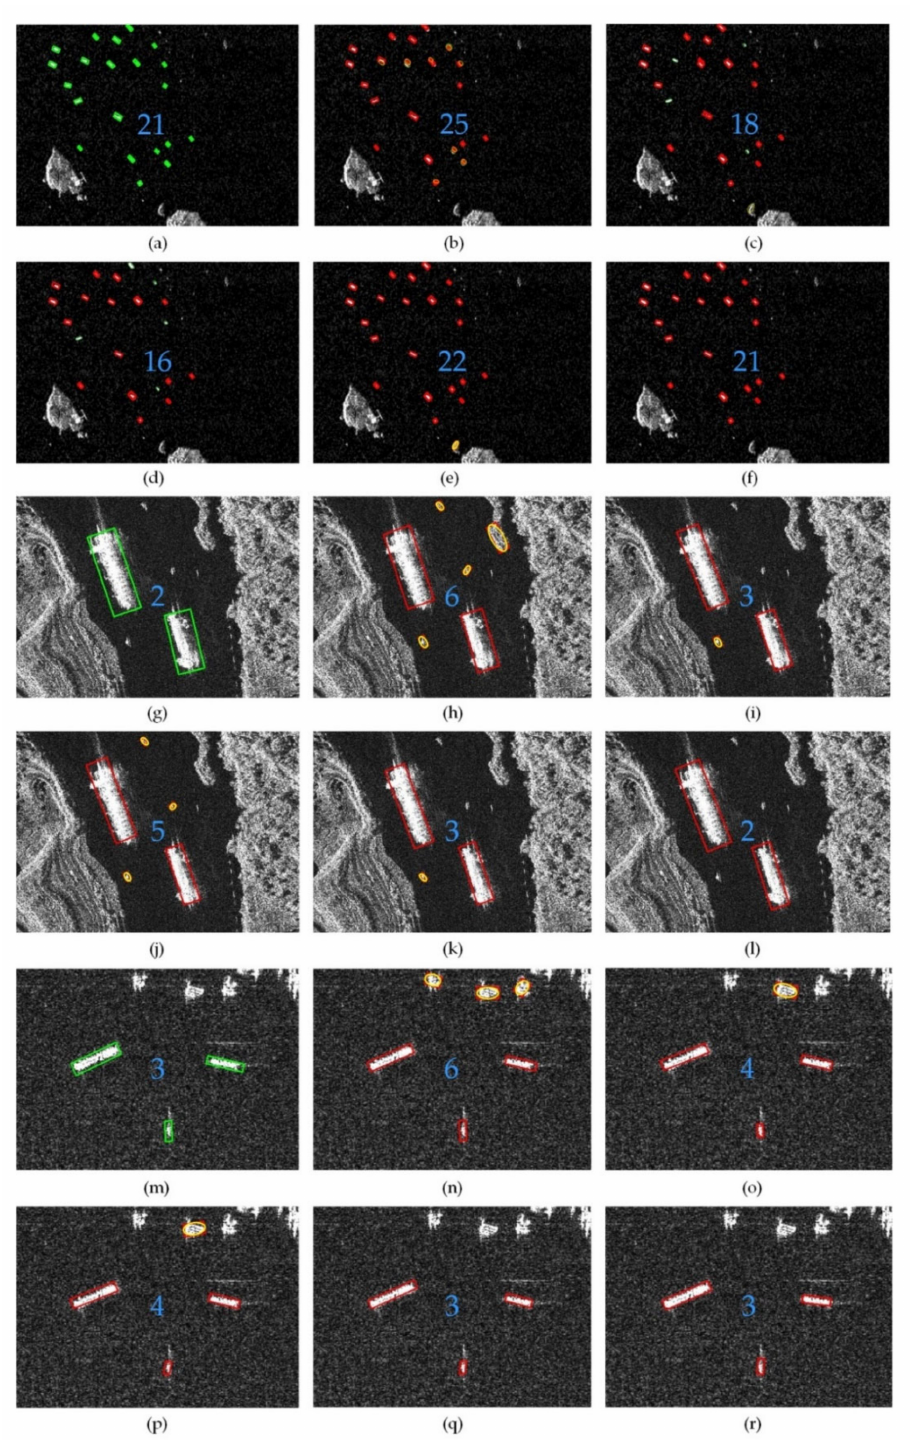
Figure 15. Detection results of different CNN-based methods on SSDD. ( a , g , m ) ground-truths. ( b , h , n ) results of DRBox-v1. ( c , i , o ) results of SDOE. ( d , j , p ) results of DRBox-v2. ( e , k , q ) results of improved R-RetinaNet. ( f , l , r ) results of proposed BiFA-YOLO. Note that the red boxes represent true positive targets, the yellow ellipses represent false positive targets and the green ellipses represent missed targets; the blue number represents the number of detected